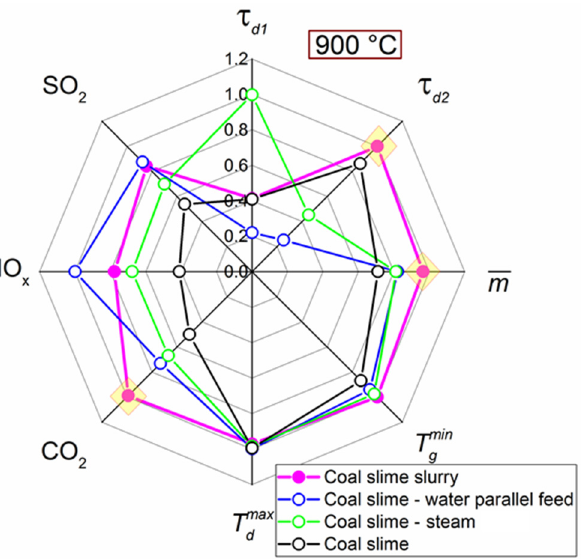
Figure 15. Efficiency indicators of the examined methods of coal slime combustion with water (at a temperature of 900 ° С in the combustion chamber).